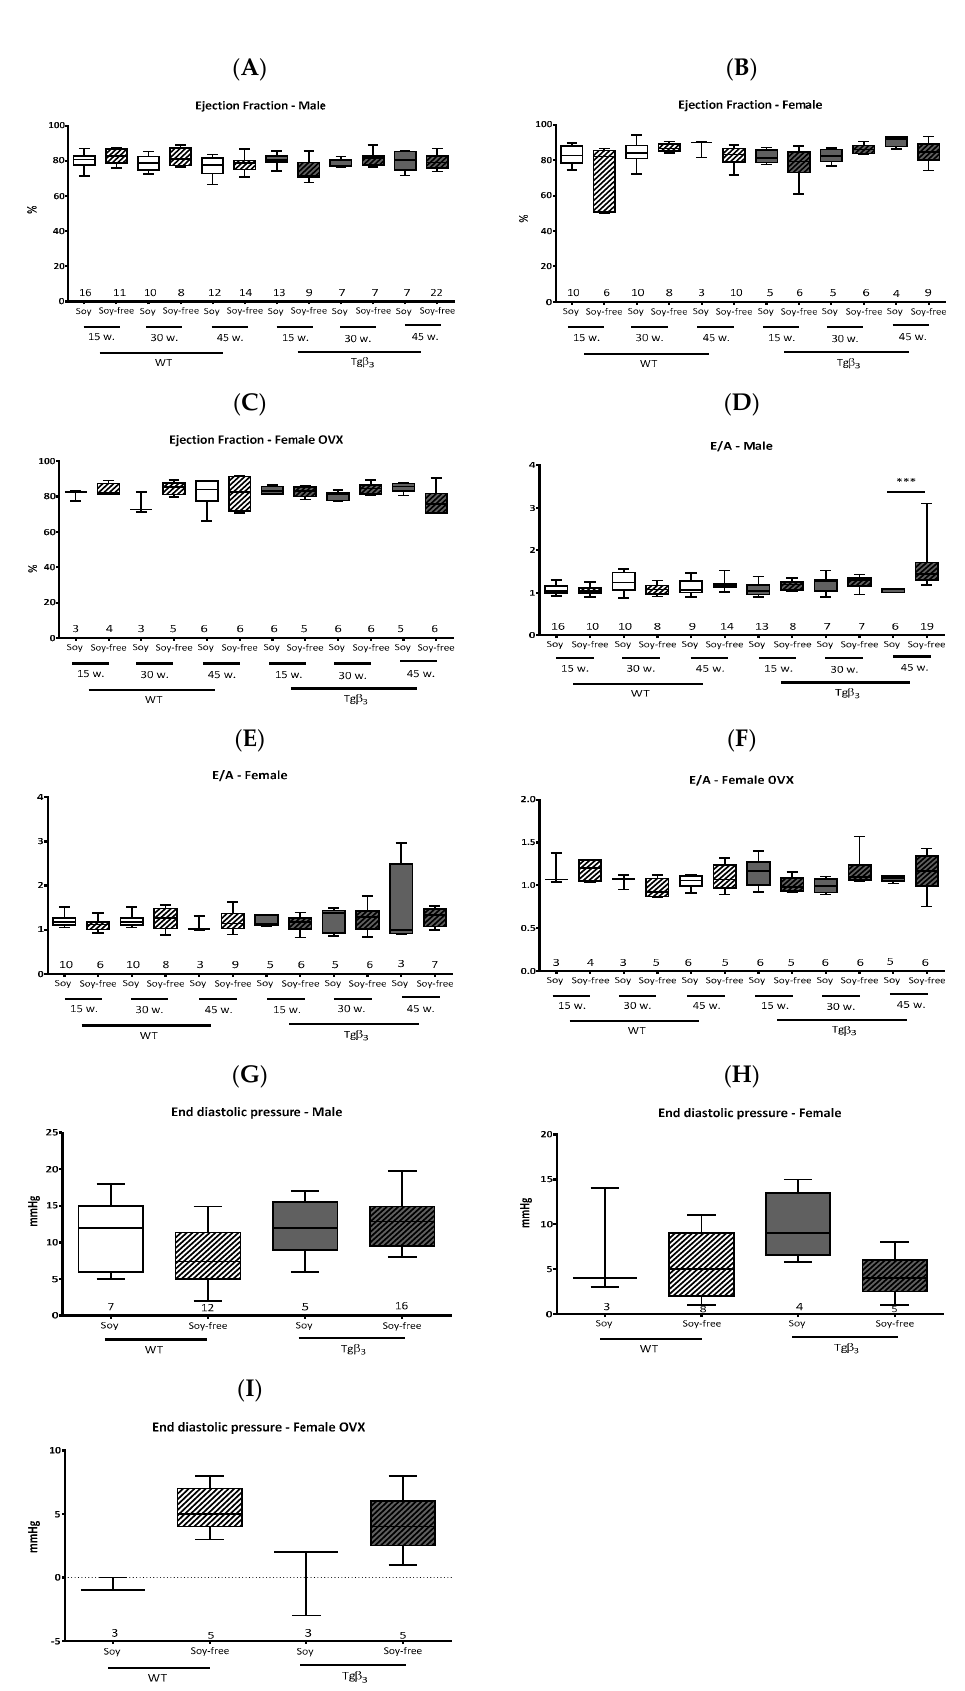
Figure 1. Echocardiography study at 15, 30 and 45 weeks of age and invasive hemodynamic study at 45 weeks of age depending on the rodent diet; with or without soy. We evaluated the ejection fraction on male ( A ), female ( B ) and ovariectomized